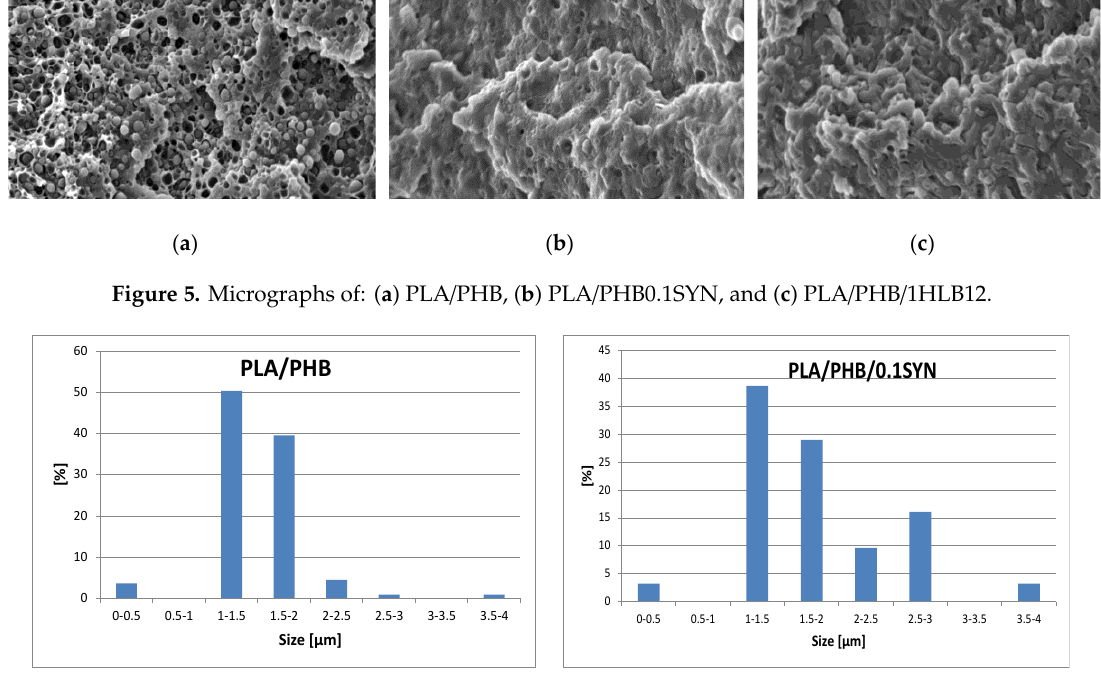
Figure 6. Particle size distribution of the neat blend and 0.1Syn-containing system.